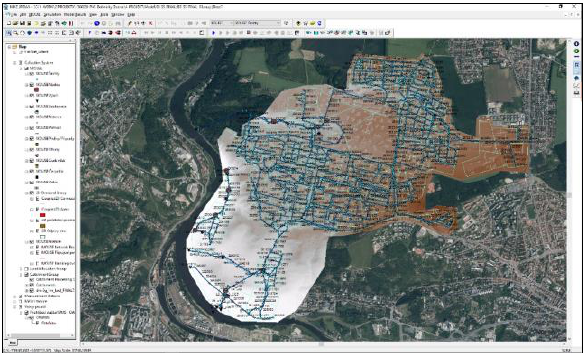
Figure 6. Final setup of simulation model MIKE Urban